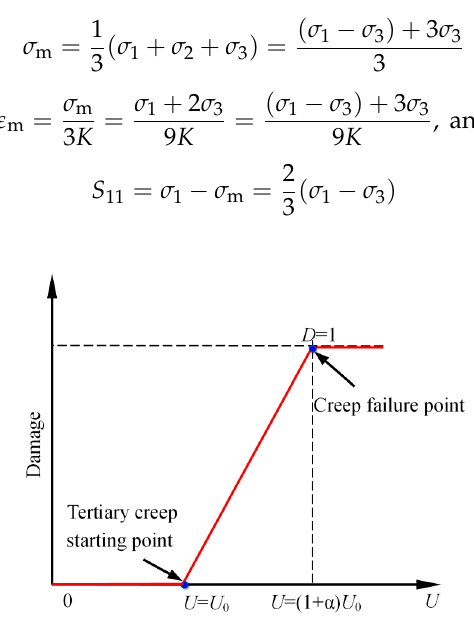
Figure 9. Rock damage evolution trend.